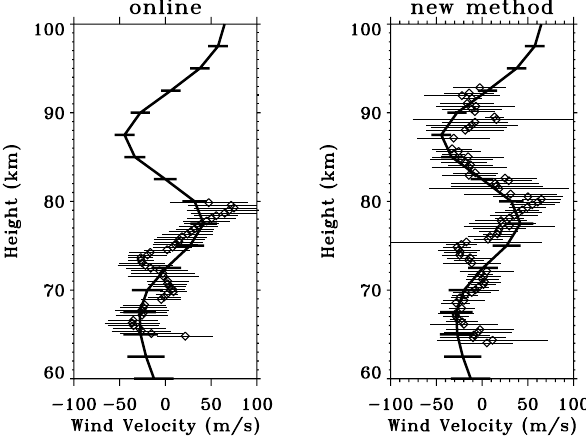
Fig. 6. Comparison of the meridional wind profiles between HRDI (thick line) and the MU Radar (squares) with 15 minute resolution data and the standard deviation (thin line) on 18 October 1994. The HRDI overpass over the MU radar occurred at 11:10 LT. The wind velocity for the MU radar in the left figure is that obtained by on- line fitting, and that in the right figure is that obtained by the new method with a time resolution of 15